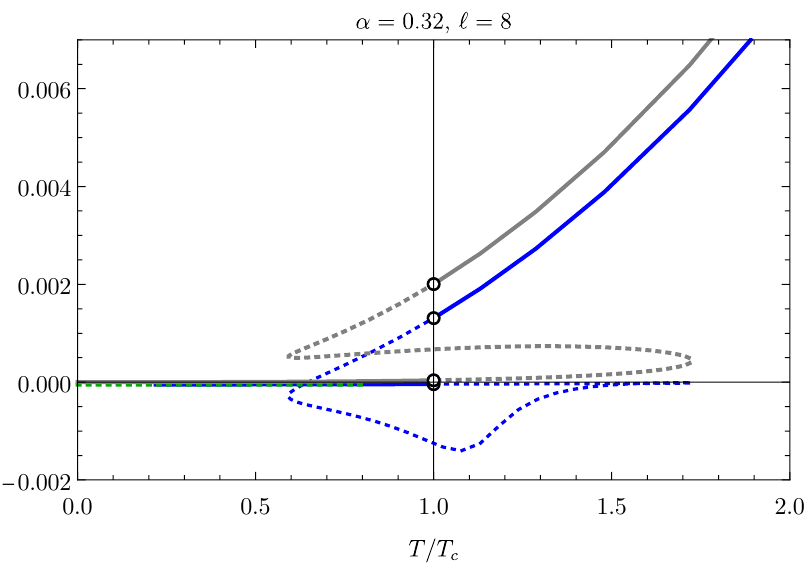
Figure 17 . QNEC 2 as function of T for black brane solution with α = 0 . 32 and ‘ = 8 . Blue lines (cid:0) (cid:1) show the QNEC 2 expression 1 S 00 + 6 ( S 0 ) 2 and gray lines show h T kk i , where solid (dashed) parts 2 π c of the curves correspond to thermodynamically stable (unstable) phases. In addition, the dashed green curve shows the value of QNEC 2 of the corresponding T = 0 domain wall solution.